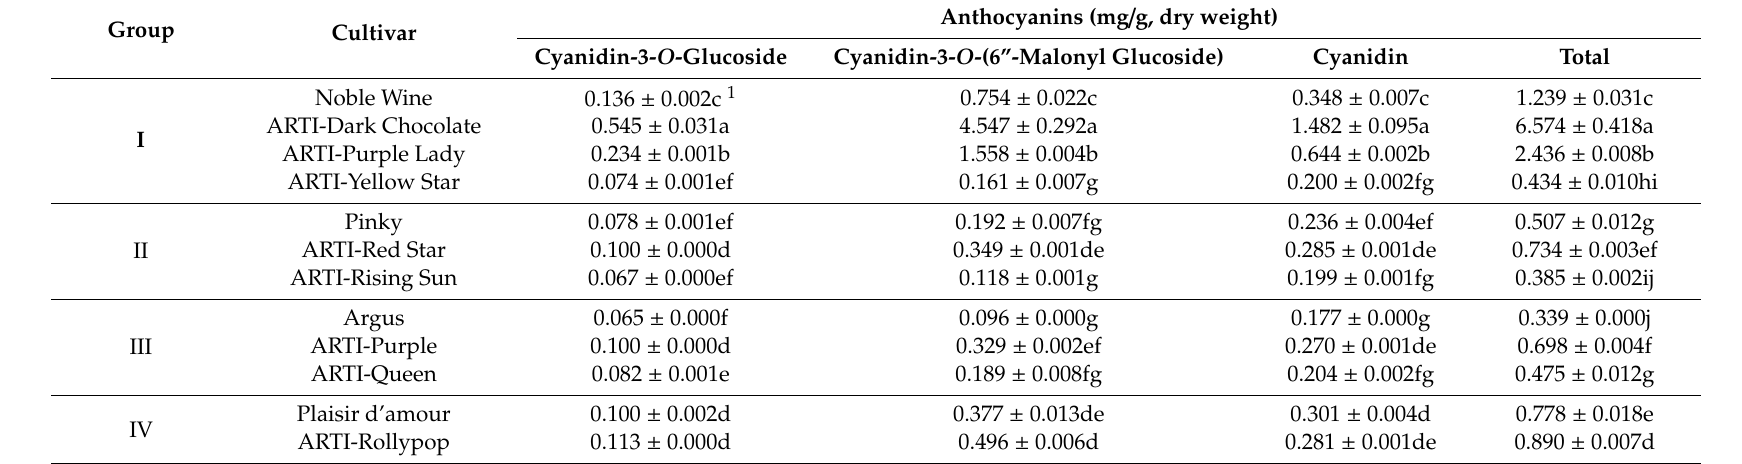
Table 2. Anthocyanin contents of the chrysanthemum